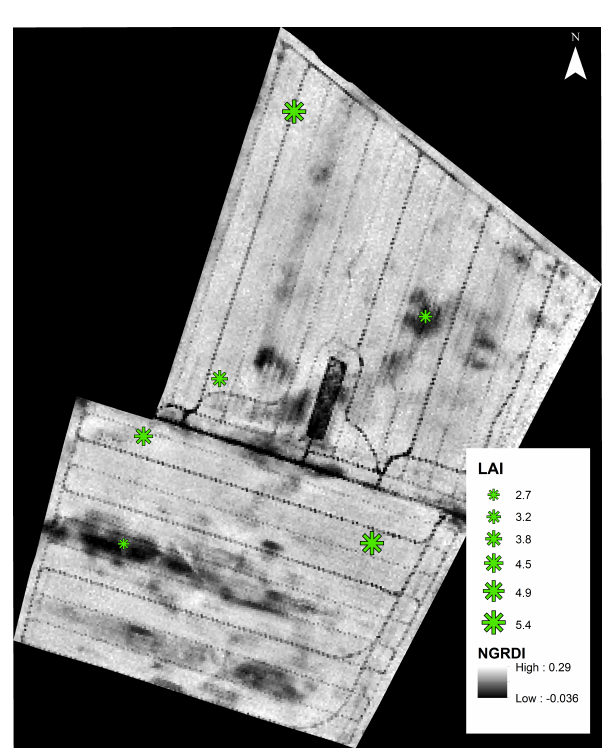
Figure C1. Location and size of LAI measurements on NGRDI map from 18 June. Size of green stars indicates the magnitude of LAI, according to the legend. Darker areas on the background map repre- sent low NGRDI values and areas with ripe/yellow crops. Brighter areas represent high NGRDI values with high green canopy cover. A correlation coefficient of 0.86 is obtained between NGRDI and